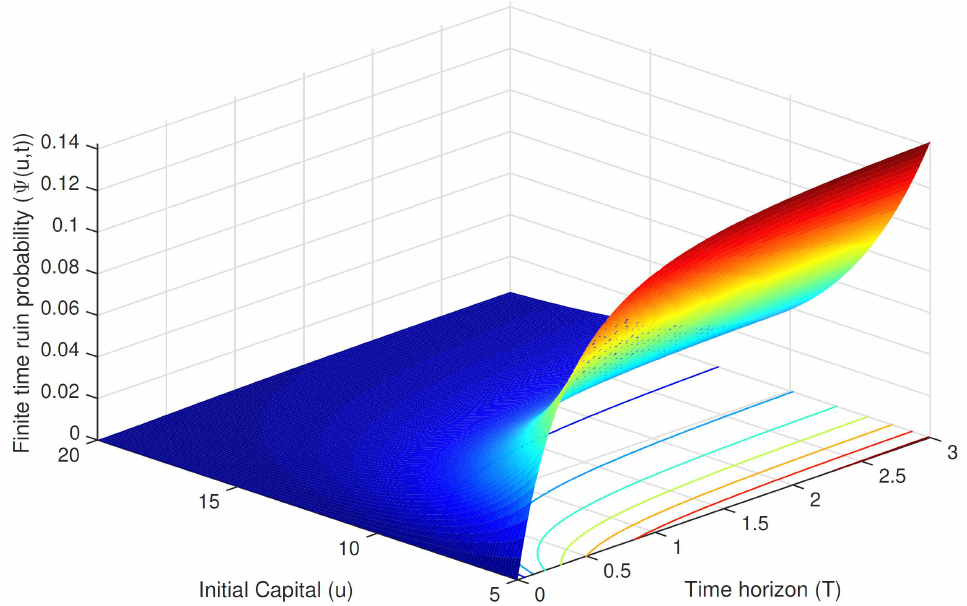
Figure 5. Plot of finite-time ruin probability: this is a numerical approximation showing how the initial capital and the time horizon affect the finite-time ruin probability. Initial capital varies from 10 to 20, time horizon ranges from 0 to 3, h = 0.005, τ = 0.01, K = 12, and other parameters are as